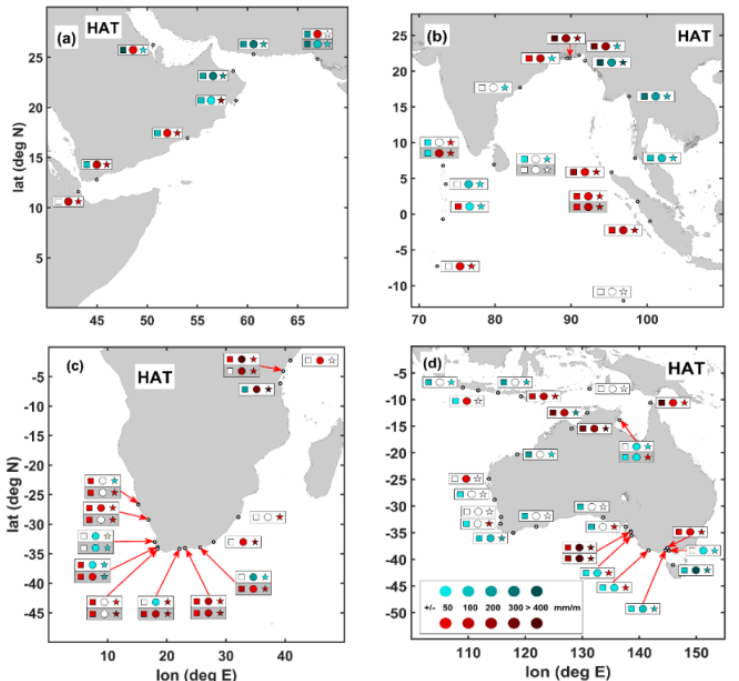
Figure 12. δ -HAT (combined M2, S2, K1, and O1 detrended tidal variations) in four different regions of the Indian Ocean: ( a ) the Arabian Sea, ( b ) the Bay of Bengal, ( c ) Africa, and ( d ) the Australian region. Symbols inside boxes indicate three different frequency bands: squares are the sub-annual (SA) band, circles are the annual (ANN) band, and stars are the interannual (IA) band. Station names are also indicated. Color shading of the symbols indicate positive (shades of red) and negative (shades of blue) δ -HATs according to legend at the bottom right (refer to